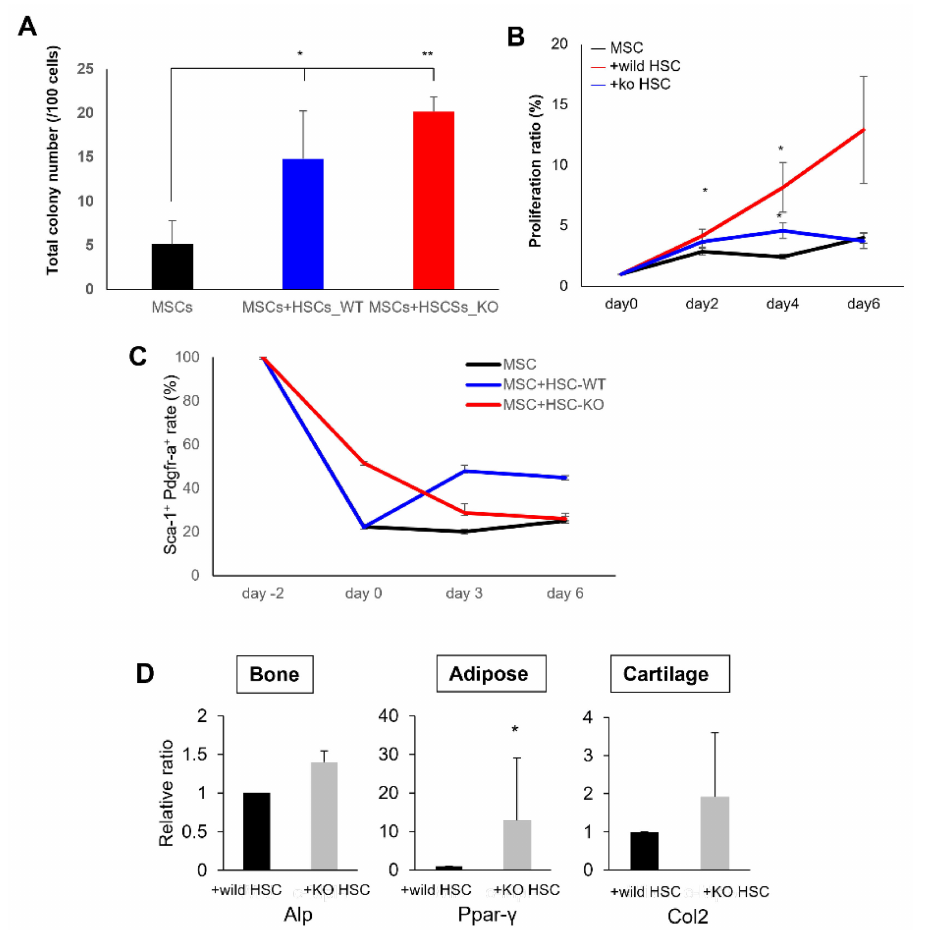
Figure 6. The c-Mpl in HSCs regulates the properties of MSCs . ( A ) Total numbers of CFU-Fs counted on day 14 after co-culture with HSCs (c-Mpl-WT and c-Mpl-KO). ( B ) Proliferation rate of MSCs after co-culture with HSCs (c-Mpl-WT and c-Mpl-KO) for 2, 4, and 6 days. * p < 0.05 ( n = 5). ( C ) Percentages of PDGFR- α - and Sca-1-positive cells in the MSCs co-cultured with HSCs (c-Mpl-WT and c-Mpl- KO). ( D ) Real-time PCR analysis for tri-lineage marker expression in MSCs following a 2-week treatment with mesenchymal differentiation media after co-culture with c-Mpl-WT or c-Mpl-KO HSCs. * p < 0.05, ** p < 0.01 ( n =